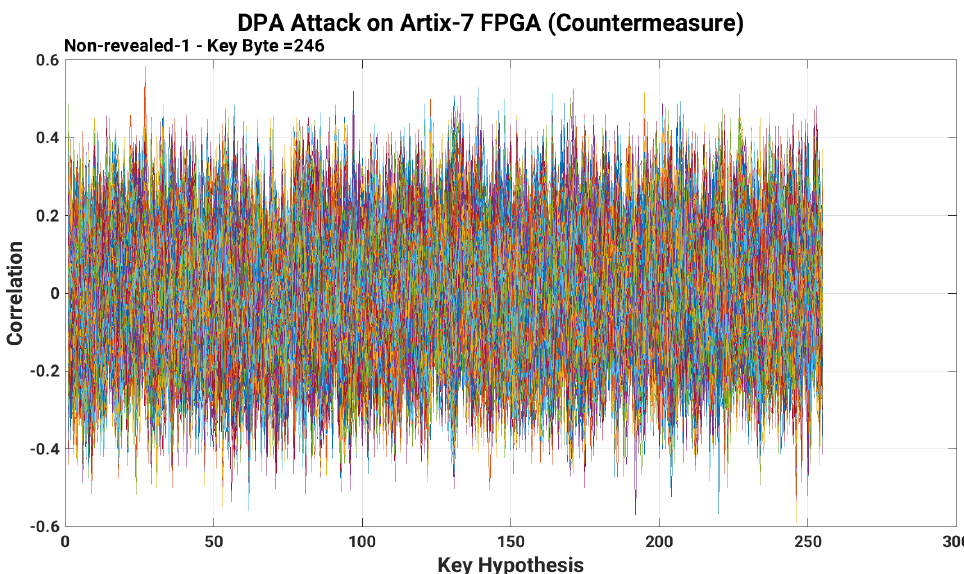
Figure 5. An erroneous retrieval of the first-byte of a 128-bit secret key obtained after the execution of a DPA attack on DESIGN-II (AES with inclusion of our proposed